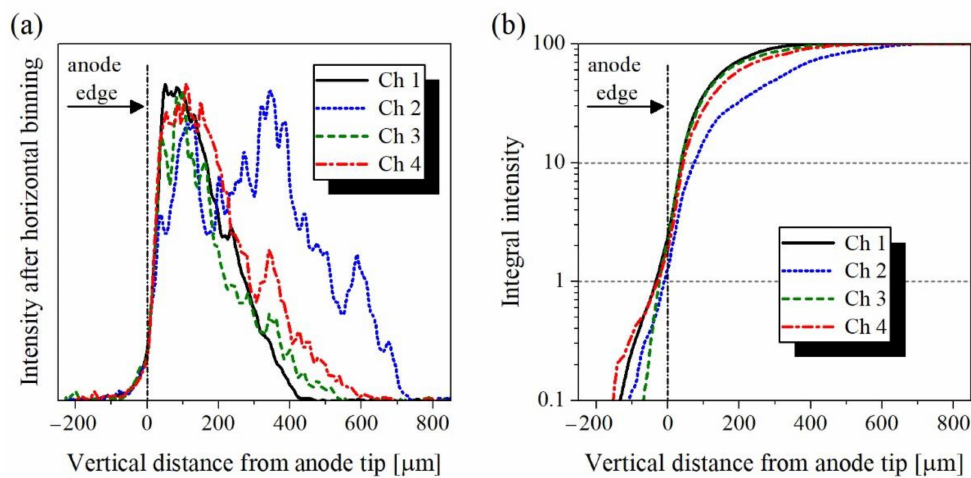
Figure 15. Distribution of the total registered luminous flux at a wavelength of 532 nm along the axis of symmetry of the anode pin after ( a ) horizontal binning and ( b ) subsequent integration from bottom to top. Vertical distance equal zero corresponds to the tip of the anode. Evaluated from the Event 1 image sequence shown in Figure